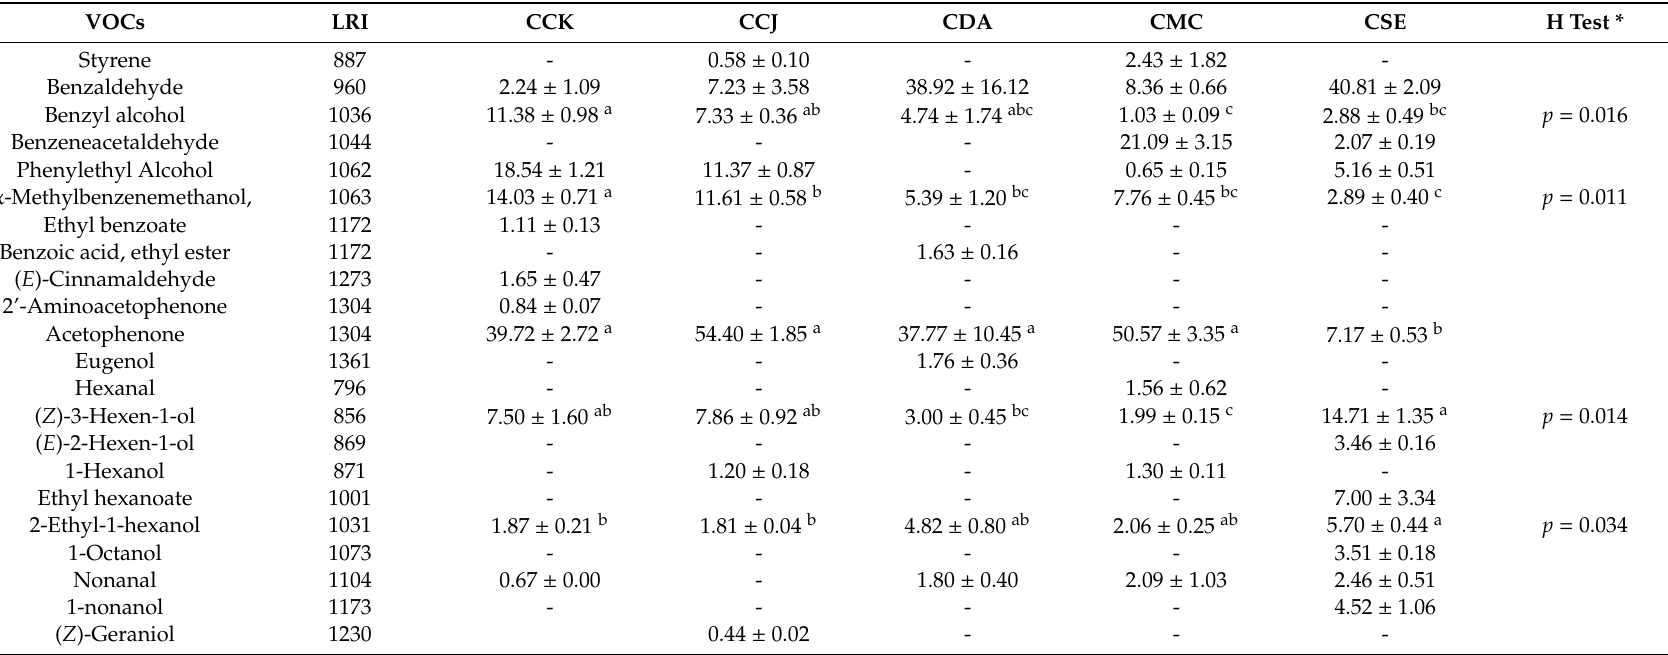
Table 4. Identified VOCs in floral nectar of Castenea spp.